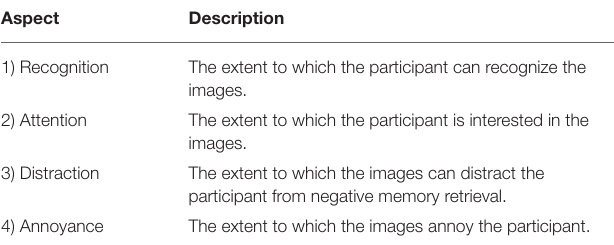
TABLE 1 | Aspects of post-experiment questions.